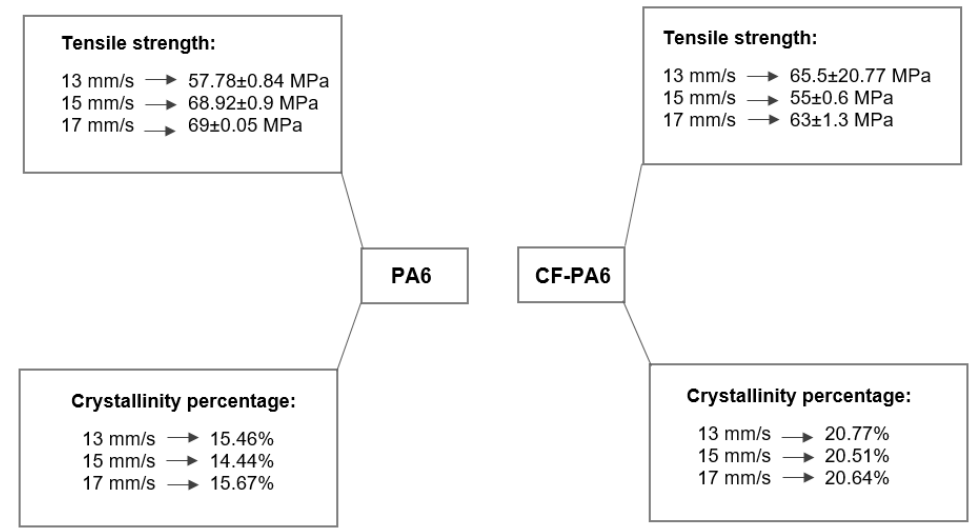
Figure 2. Obtained tensile strength and crystallinity percentage values concerning the print speed effect investigation .